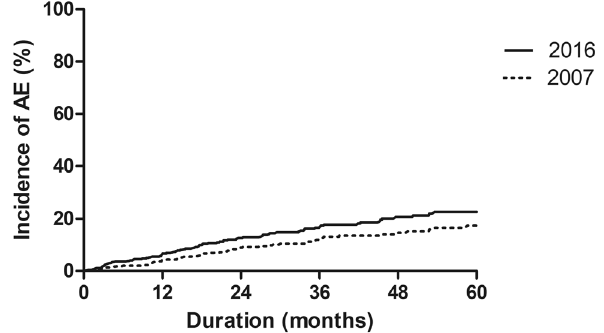
Figure 1. Comparison of incidence of AE of IPF according to 2007 and 2016 definition of AE. AE acute exacerbation, IPF idiopathic pulmonary